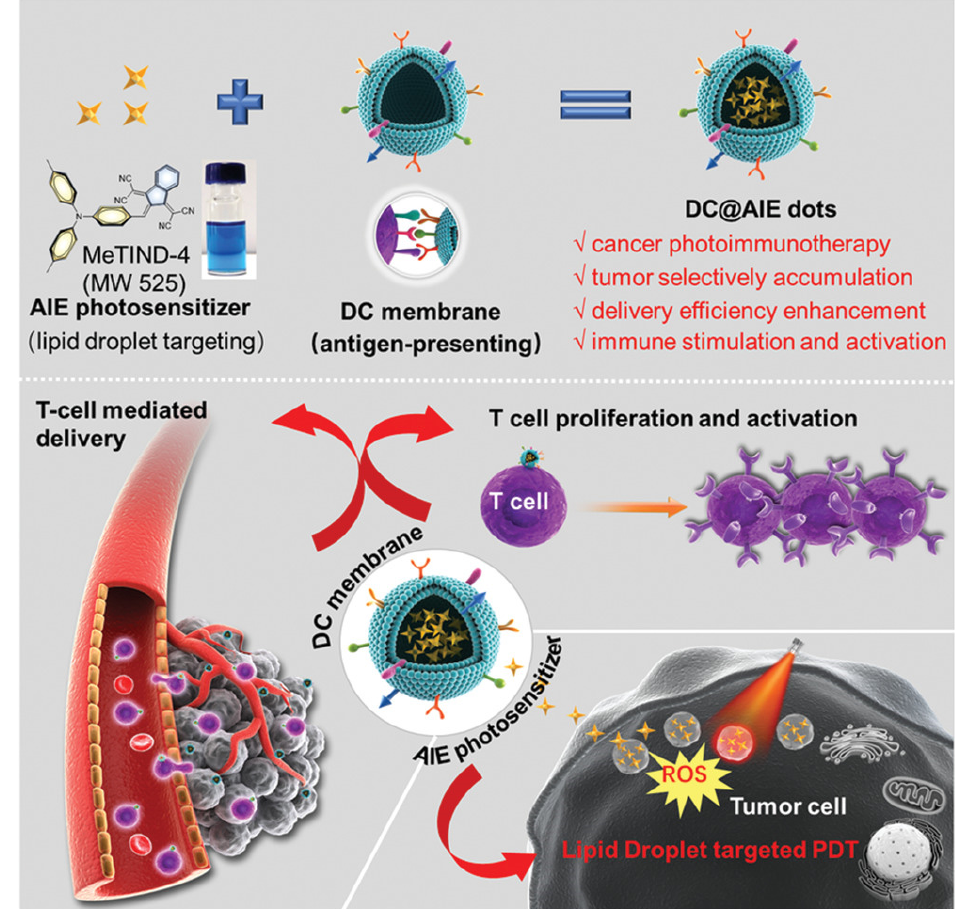
Figure 11. The schematic illustration represents preparation and assembly of AIE photosensitizers with DC membrane coating (DC@AIEdots) and in vivo photodynamic immunotherapy. Reprinted with permission from Ref. [29]. Copyright 2021 John Willey and Sons.